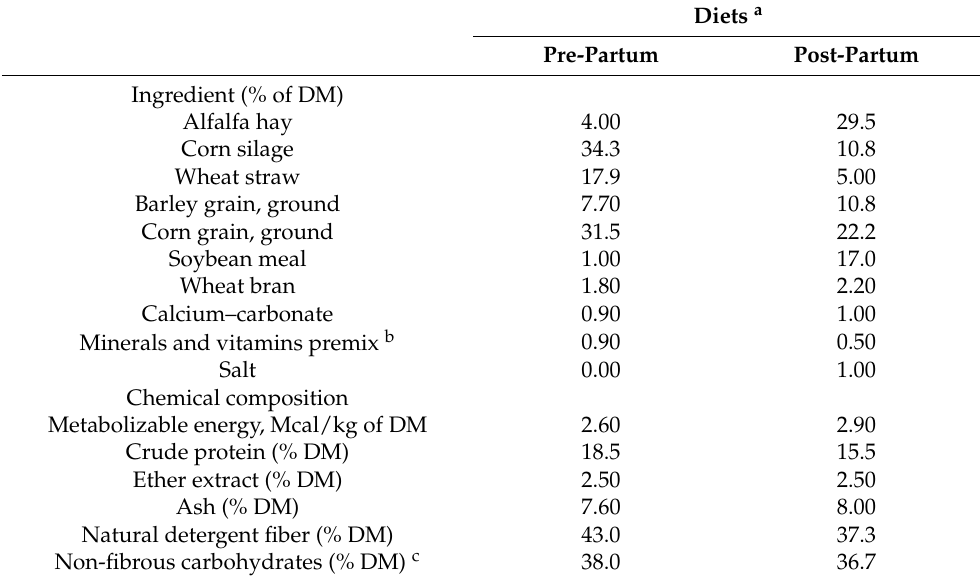
Table 1. Ingredients, chemical analysis and nutritive value dry matter (DM) basis of the pre- and post-partum basal total mixed